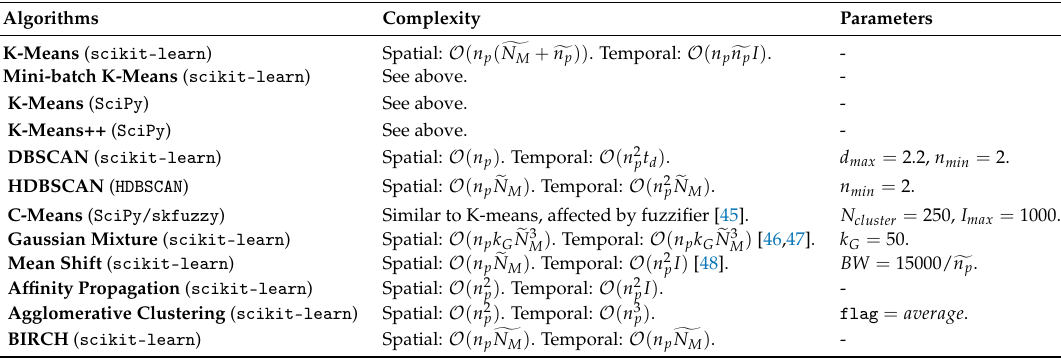
Table 1. Summary of the spatial algorithms